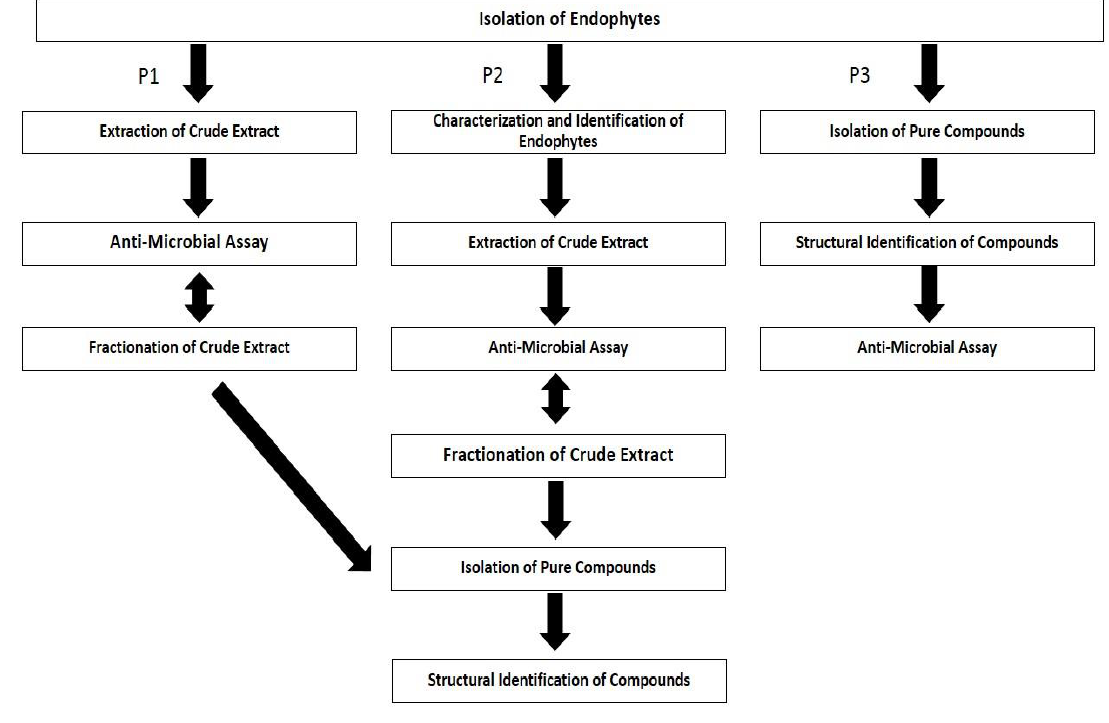
Figure 4: Designs in Isolation of Bioactive